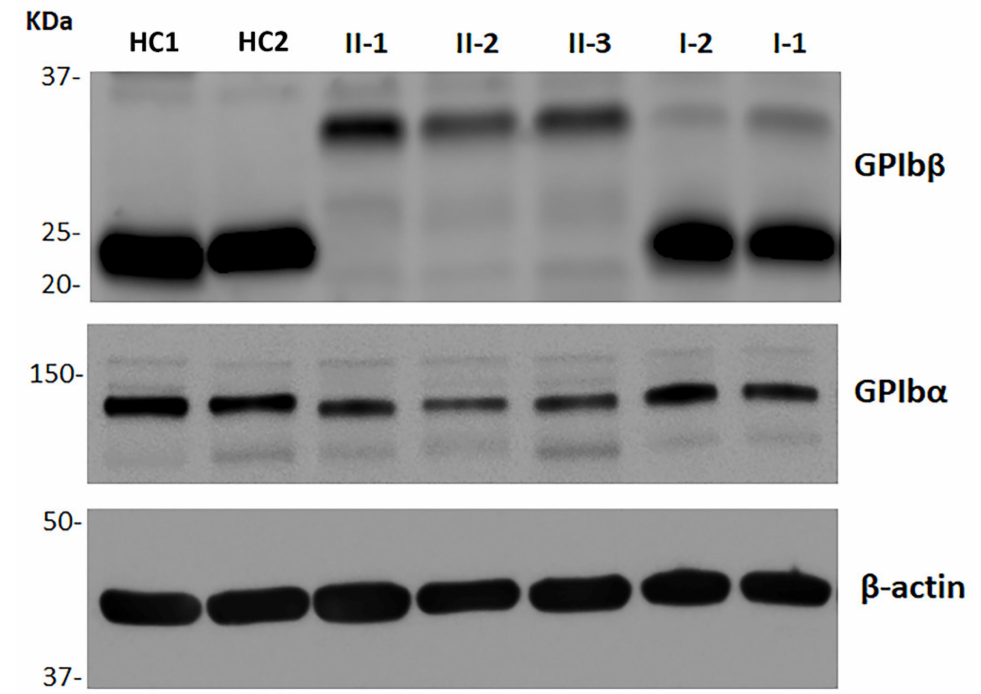
Figure 2. Representative image of the results of the immunoblotting assay for investigation of the total platelet amount of GPIb β and GPIb α . Whole platelet lysates were obtained from washed platelets of the three patients (II-1, II-2, and II-3), their parents (I-1 and 1-2), and different healthy controls (HCs). β -actin was used as the protein loading control. The results of the densitometric analysis are expressed as the GPIb β / β -actin and GPIb α / β -actin ratios (see Table 3). Table 3. Densitometric analysis of the GPIb β and GPIb α bands obtained with immunoblotting assay.